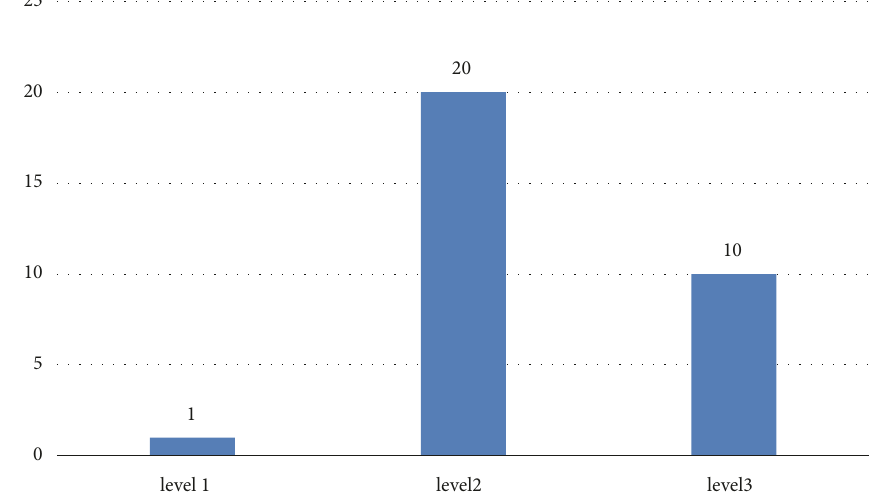
Figure 1: Brighton criteria level of diagnostic certainty of diagnosis of Guillain-Barre syndrome (n-31).